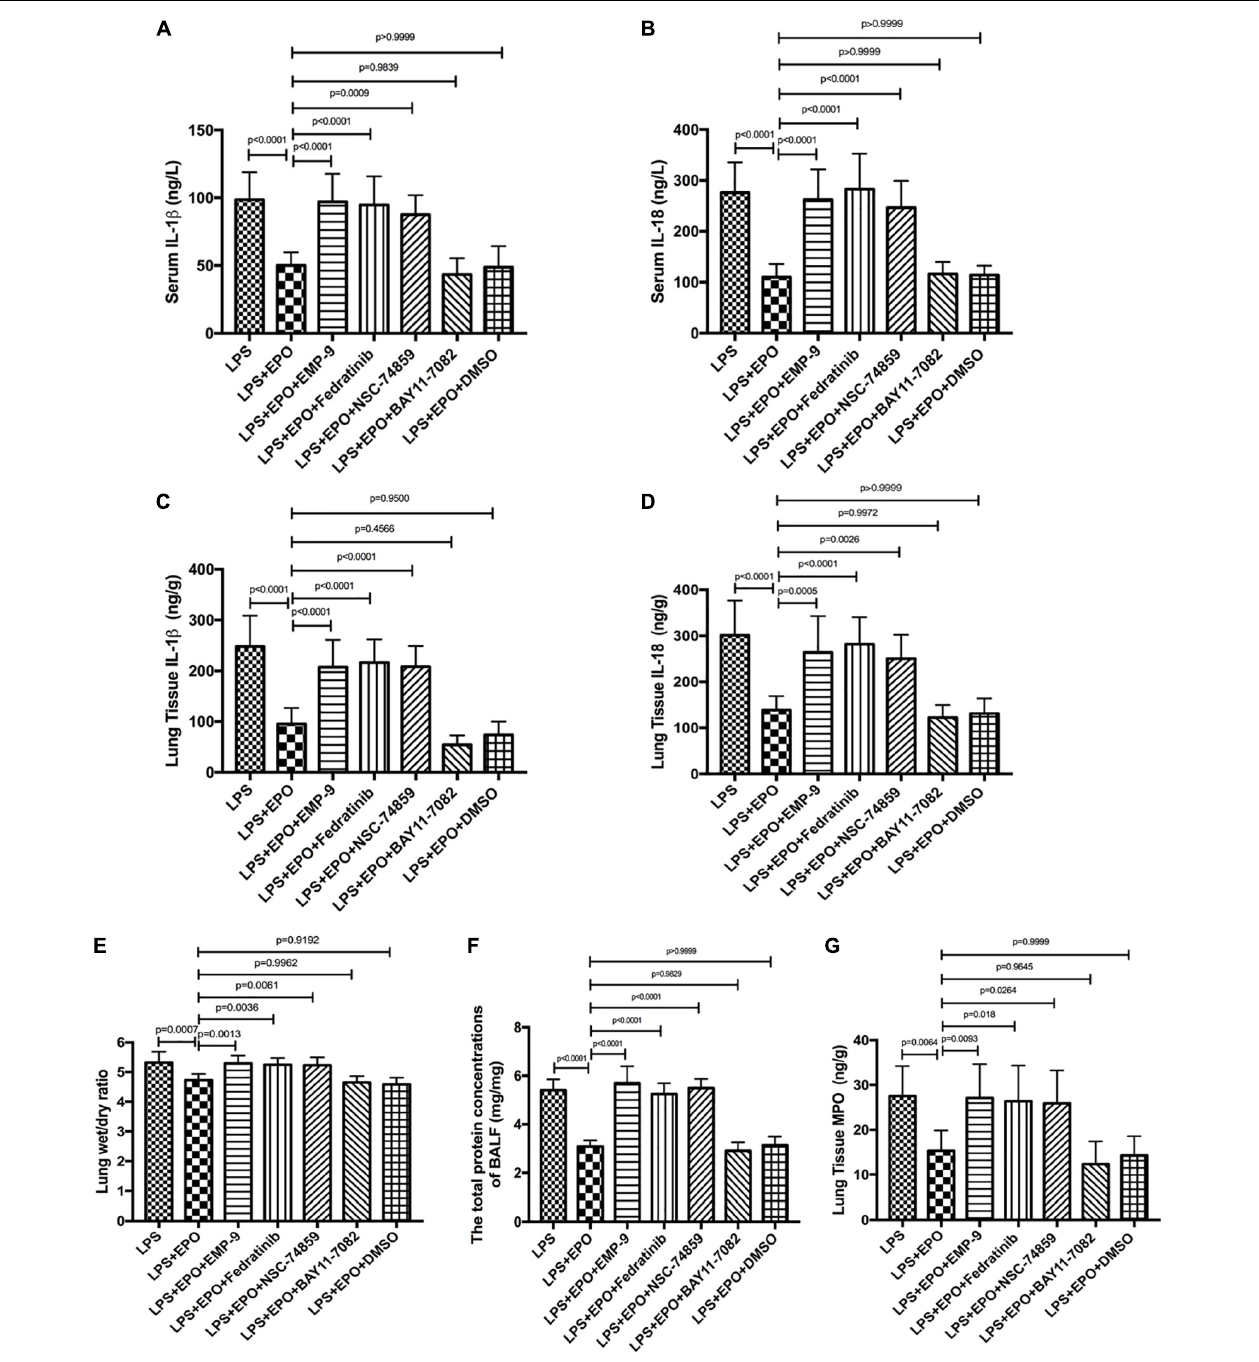
FIGURE 7 | EPO protected against lung injury through the EPOR/JAK2/STAT3 and NF- κ B signaling pathways. EMP9 (an EPOR antagonist, 1 mg/mouse), Fedratinib (a JAK2 inhibitor, 100 mg/kg), NSC 74859 (a STAT3 inhibitor, 5 mg/kg), BAY 11-7082 (an NF- κ B inhibitor, 20 mg/kg), and DMSO (solvent of the inhibitors) were injected into the peritoneal cavity 30 min before EPO treatment. Then, EPO (5 U/g) was injected into the peritoneal cavity of mice after LPS (15 mg/kg) stimulation. The mice were sacrificed 8 h later, and the sera were obtained to measure the concentrations of IL-1 β and IL-18 (A,B) by ELISA. The BALF was obtained to measure the total protein concentrations (F) . In addition, the lung tissues were harvested to measure the lung wet/dry ratio (E) , and the concentrations of IL-1 β , IL-18, and MPO (C,D,G) were measured by ELISA. The data are presented as the mean ± SD. The differences among groups were assessed by one-way ANOVA and the post hoc test (Turkey method) was applied to investigate the differences one by one. n = 8 per group.